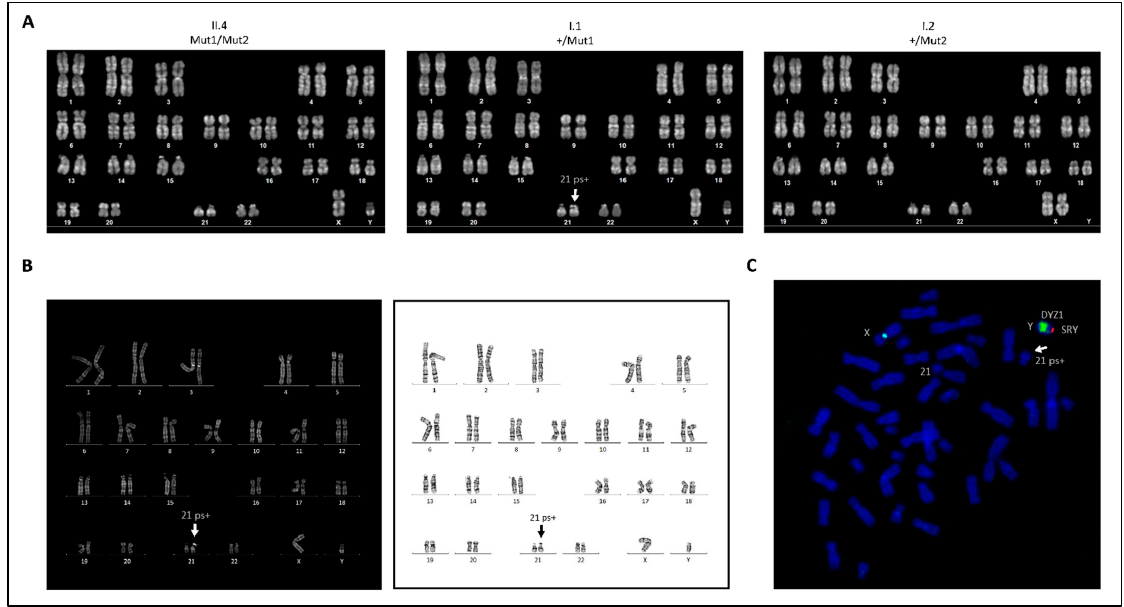
Figure 2. Karyotype analysis. ( A ) Conventional Q-banded karyograms from the hiPSCs clones of the three family members displaying a normal karyotype with no manifest cytogenetic abnormalities, except for an increase in length of the satellite on the short arm of chromosome 21 (21ps+) in the father’s line. ( B ) Conventional Q-banded and G-banded karyograms from the peripheral lymphocytes of the father displaying a normal constitutional karyotype with the 21ps+ heteromorphism. ( C ) SRY-FISH analysis performed on the father’s peripheral lymphocytes showing a normal male (XY) cell with one red signal (SRY; Yp11.31), one green signal (DYZ1; Yq12) and one blue signal (DXZ1; Xp11.1–q11.1). Both 21 chromosomes do not show any Yq-specific green FISH signal. The white arrow indicates the 21ps+ polymorphism. I.1 = father; I.2 = mother; II.4 = patient. Pluripotency competence was assessed functionally in vitro by embryoid bodies (EBs) formation assay. Human iPSCs were grown in suspension for one week. At day 7,